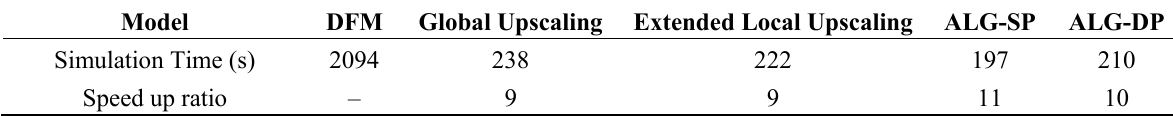
Table 2. Simulation time and speed up for case 1.